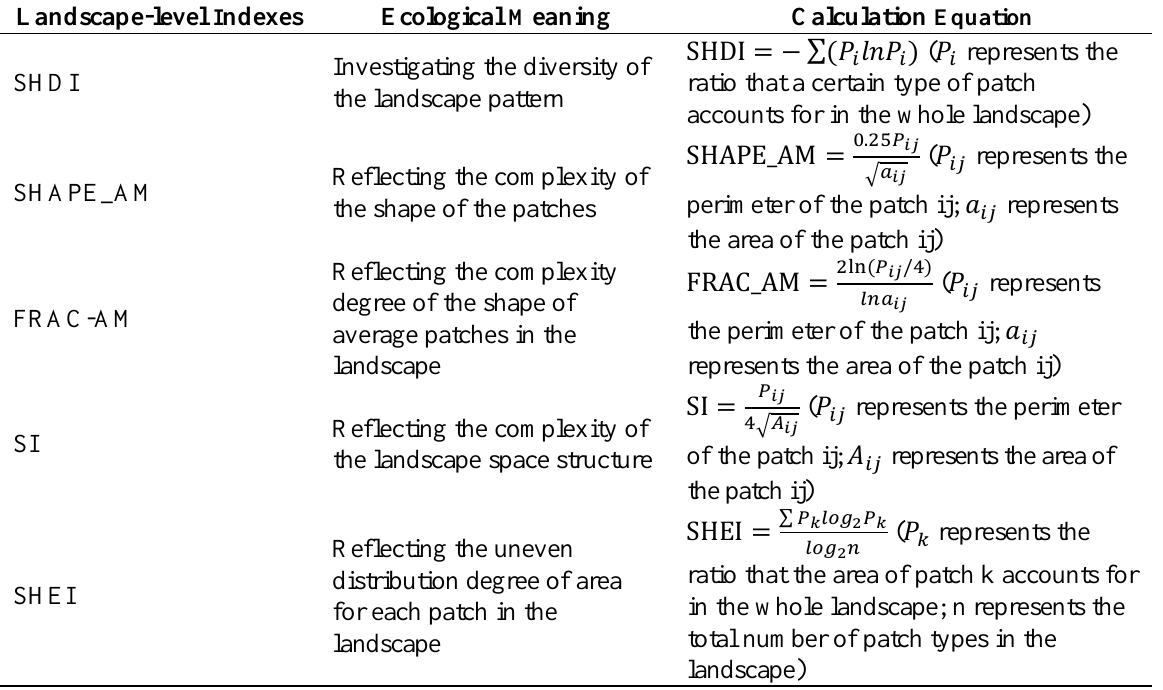
Table 2. Specific ecological meanings and calculation of the landscape-level indexes. Landscape-level I ndexes Ecological M eaning Calculation